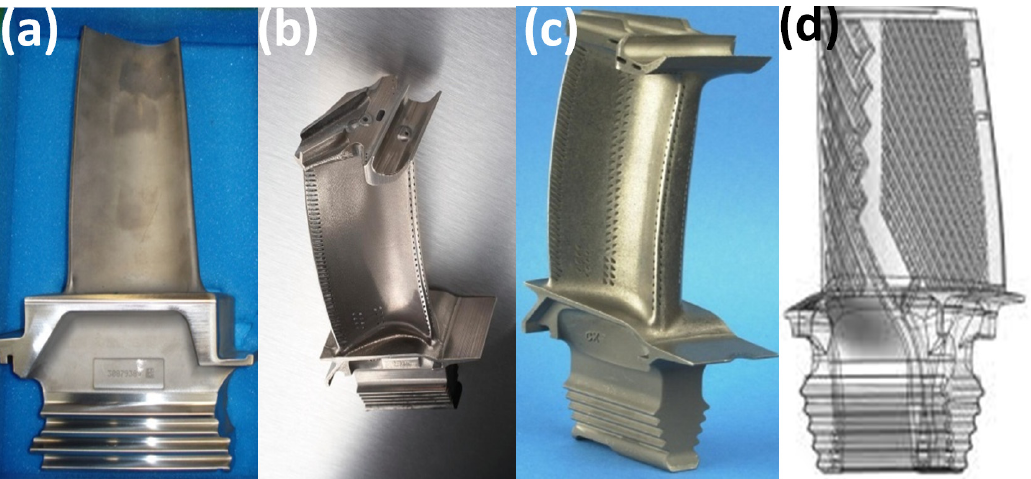
Figure 1. Various additive manufactured turbine blades. ( a ) Blade with the cooling passage at the edge, ( b ) blade with the cooling passage at both edge and middle part, ( c ) high-pressure turbine (HPT) blade [6], and ( d ) complex efficient cooling blade [7].